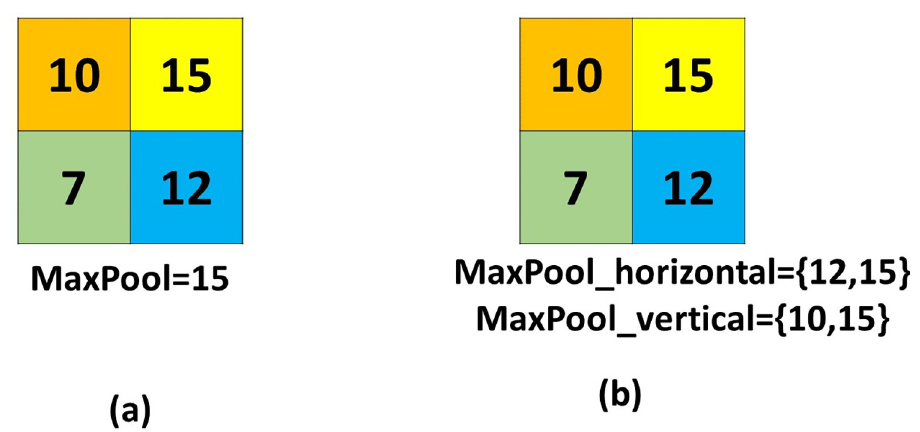
Fig 1. The difference between traditional pooling method and the proposed pooling method.